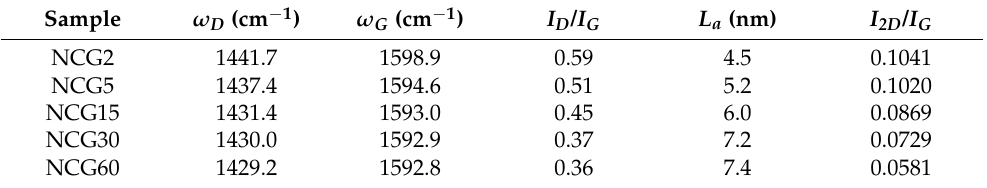
Table 2. Raman spectra parameters: ω D , ω G , I D /I G , I 2D /I G and the calculated basal plane domain size.